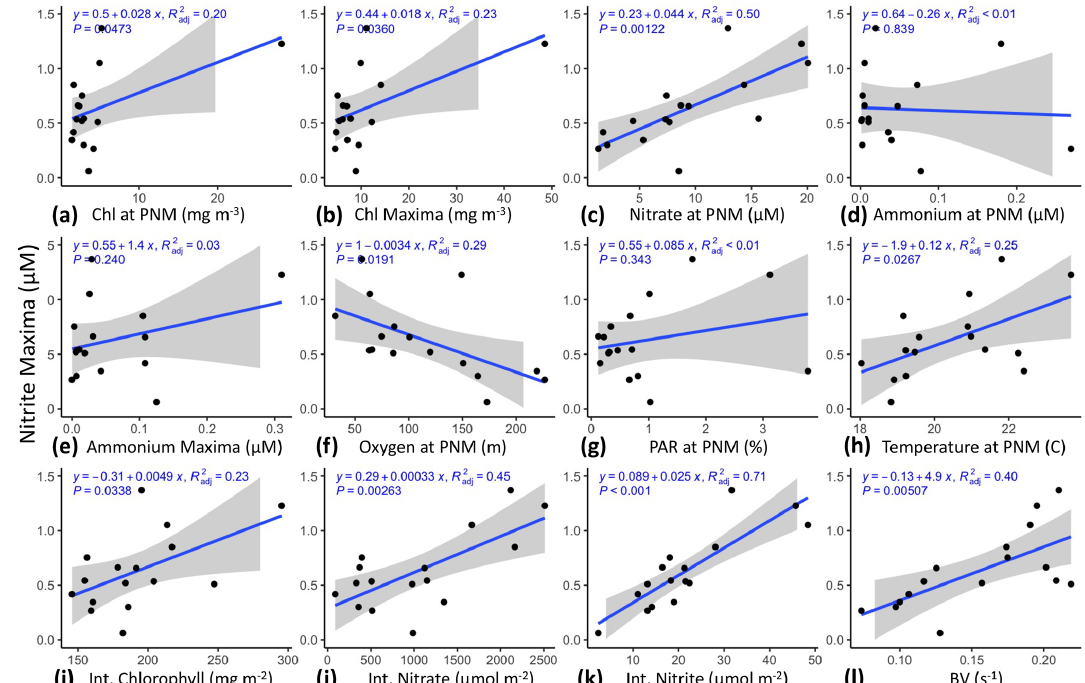
Figure 2. Linear regressions of NO − Väisälä frequencies using PPS station data from 2016 ( n = 16). Chl pnm (a) , Chl max (b) , NO − PAR pnm (g) , T pnm (h) , Chl_Int (i) , NO − standard